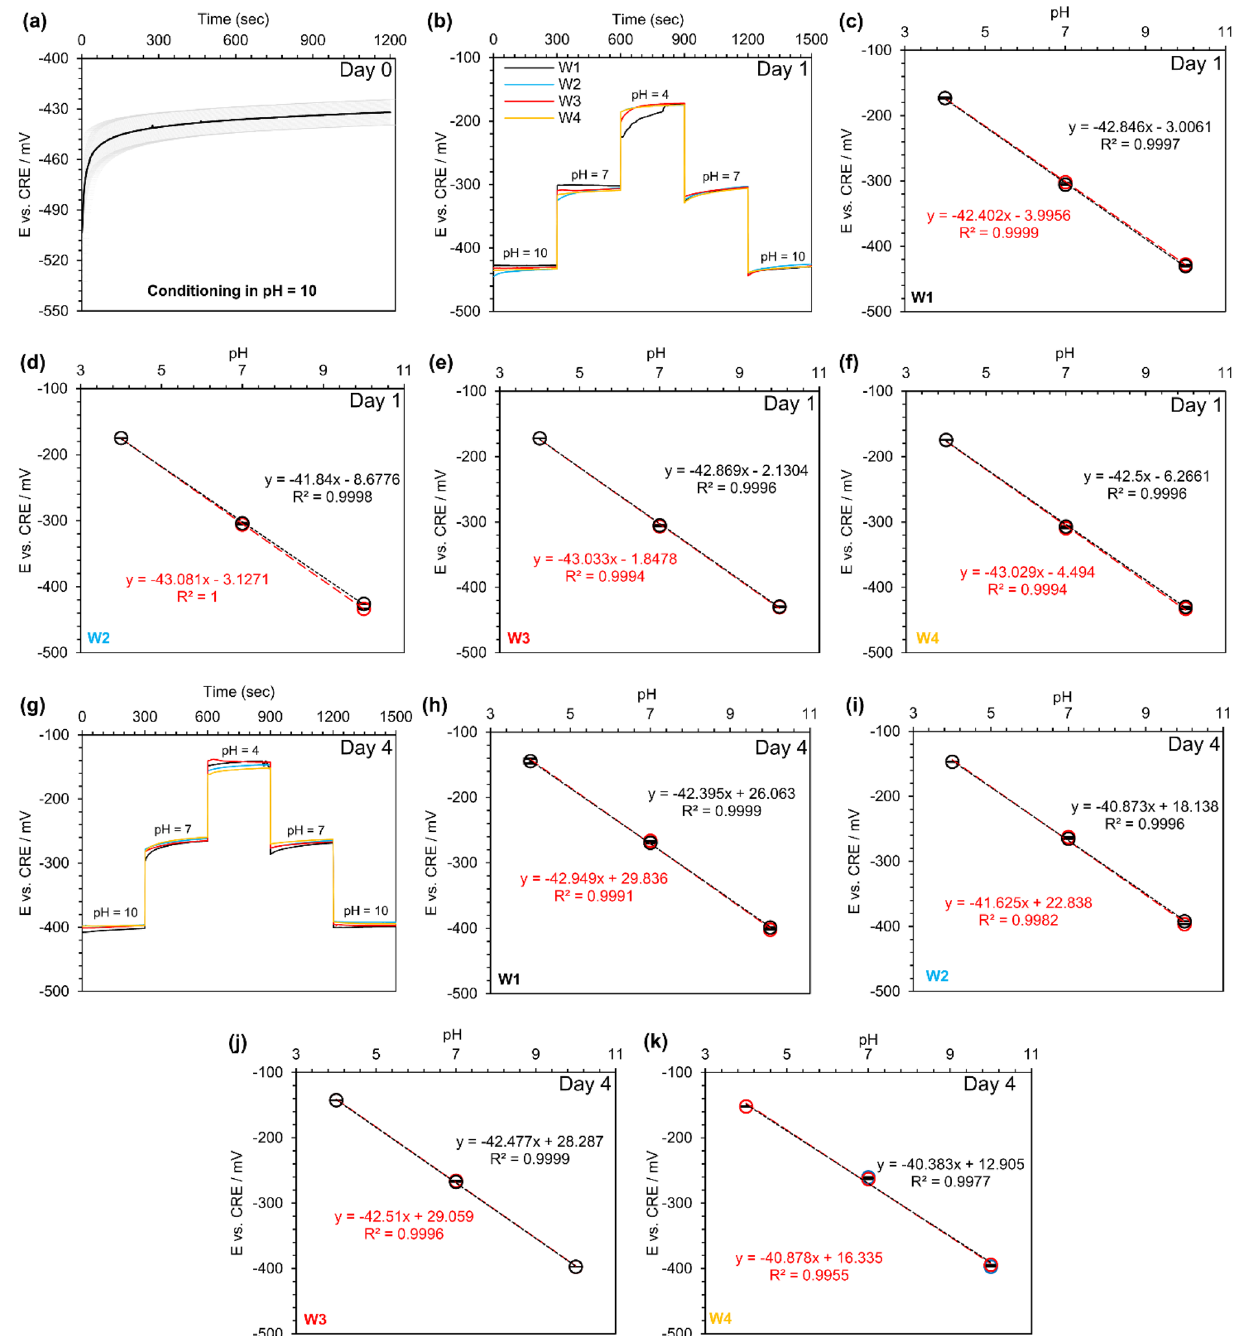
Figure 1. Open circuit potential (E) versus a commercial reference electrode (CRE) for tungsten (W) wires: ( a ) the stability testing of tungsten wires (n = 7) over 20 min in a buffer with the pH of 10, ( b ) real-time response of tungsten wires in 3 standard pH buffers (4, 7, and 10) after being conditioned in PBS (pH 7.4) for 1 day, ( c – f ) the calibration curve for each wire at day one, ( g ) real-time response of tungsten wires in 3 standard pH buffers (4, 7, and 10) after being stored in PBS (pH 7.4) for 4 days, and ( h – k ) the calibration curve for each wire at day four. N = 4. Red colors show the decrease in pH, and the increase in pH is shown in black